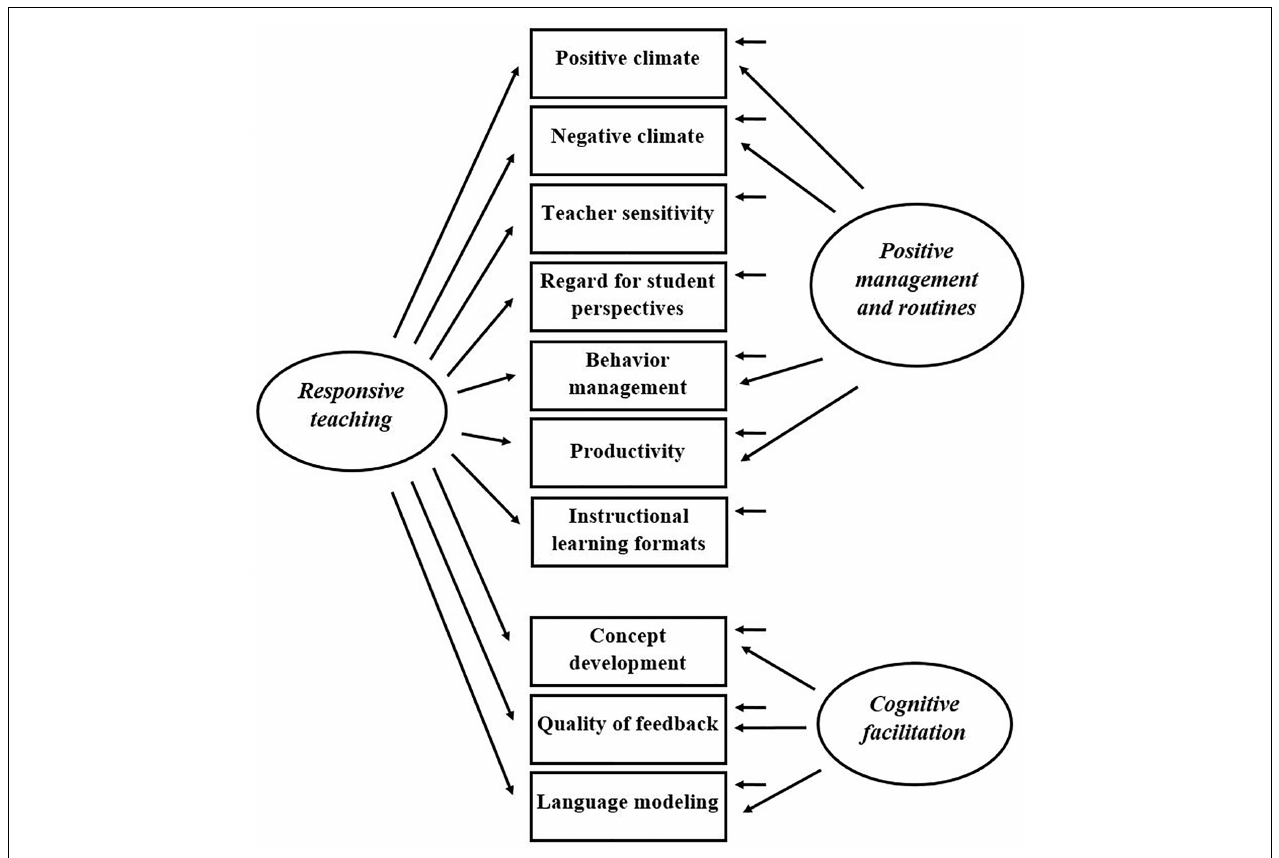
FIGURE 3 | Best fitting bifactor model proposed by Hamre et al.